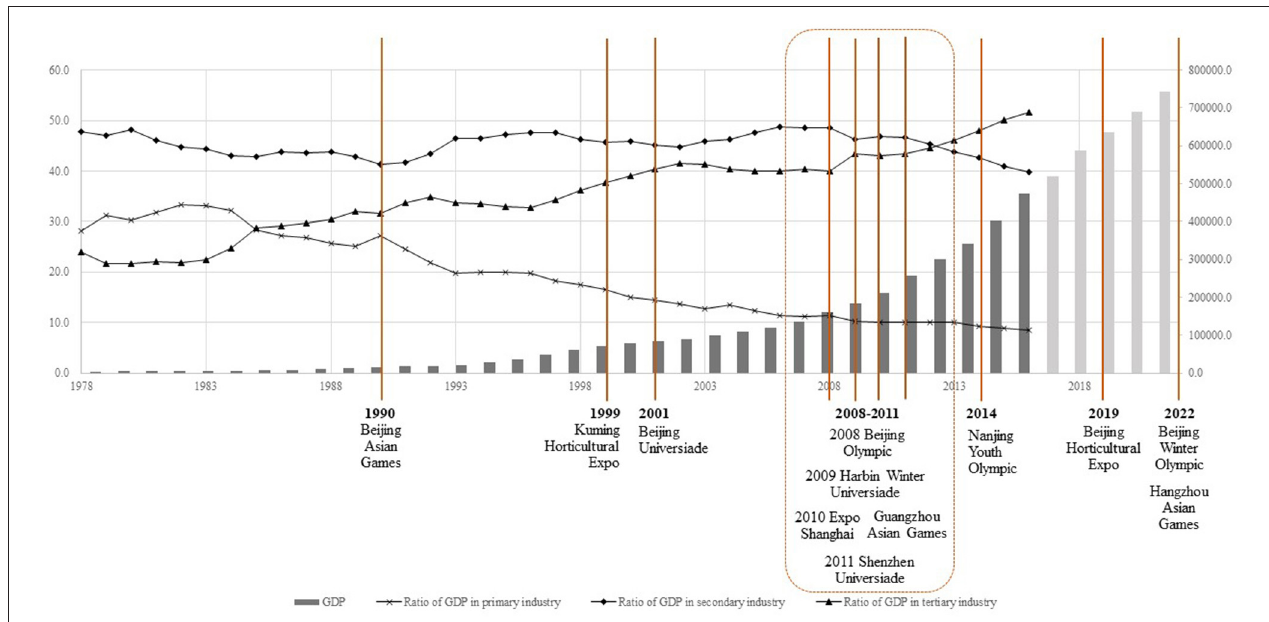
FIGURE 1 | Mega-events, accumulation, GDP growth, and structure in China (1978–2022). Source: National Statistical